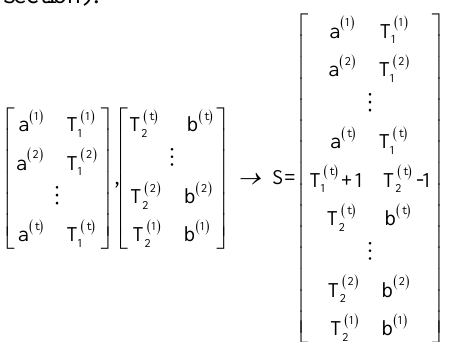
Figure 1. intervals obtained from implementation of algorithm 1.